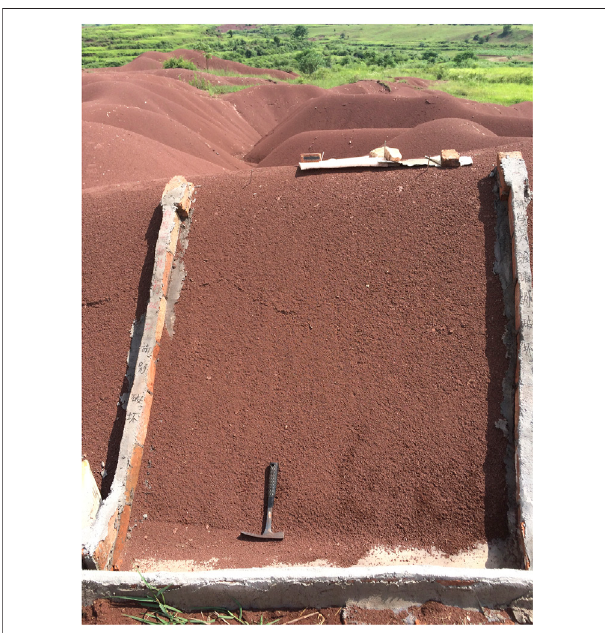
FIGURE 3 | The environment of the study site and the instruments for monitoring of erosion rates. We chose a site where the gully bottom is not steep to construct a cement platform to collect regolith depletion.